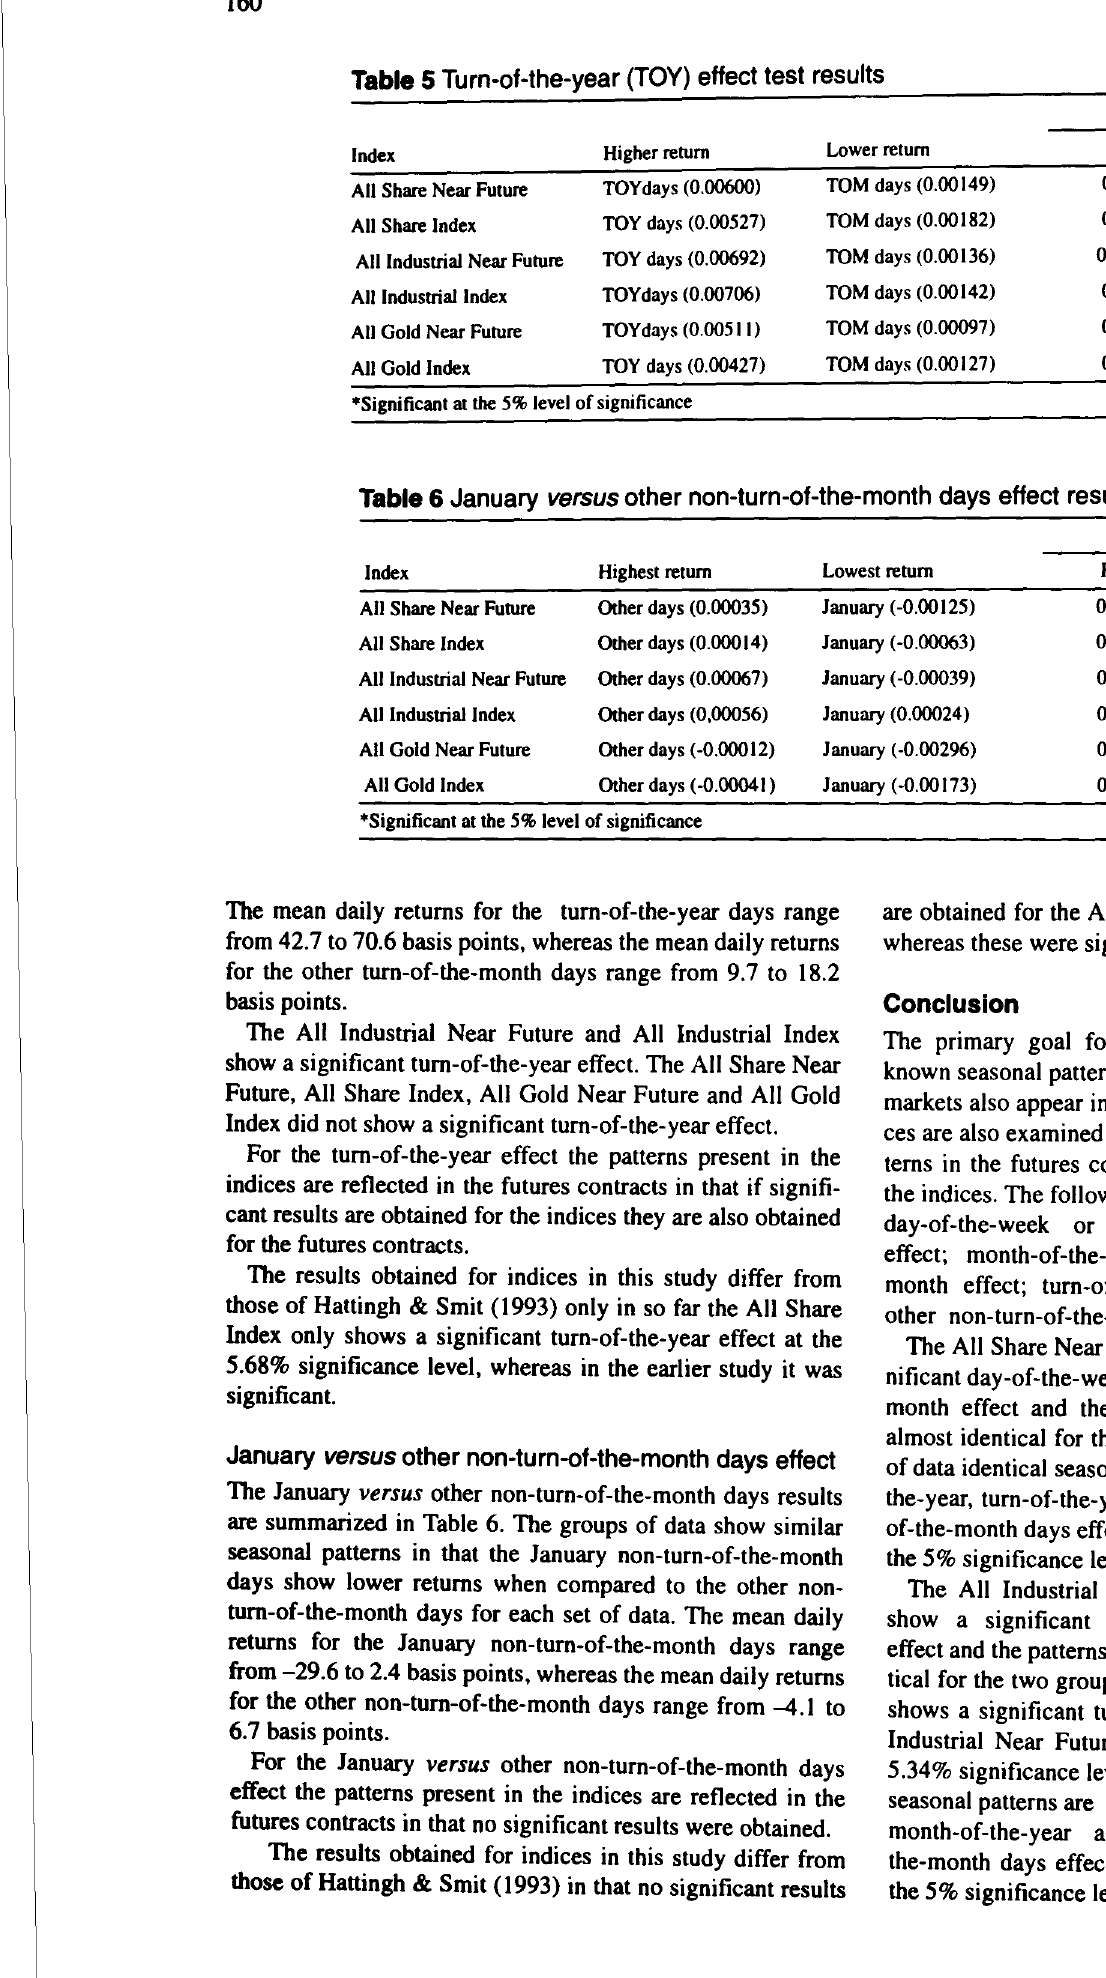
Table 5 Turn-of-the-year (TOY) effect test results